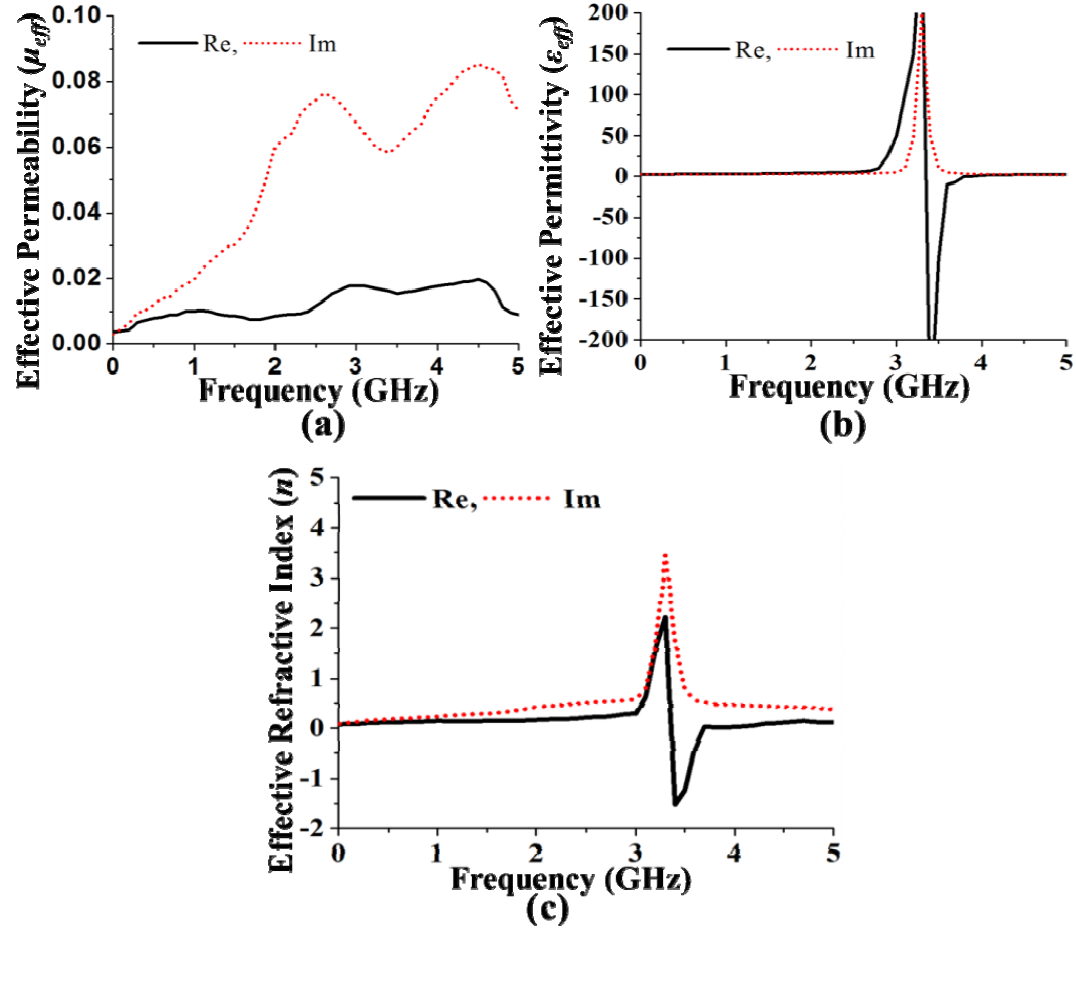
Figure 3. ( a ) Effective permeability; ( b ) effective permittivity; and ( c ) refractive index of the proposed